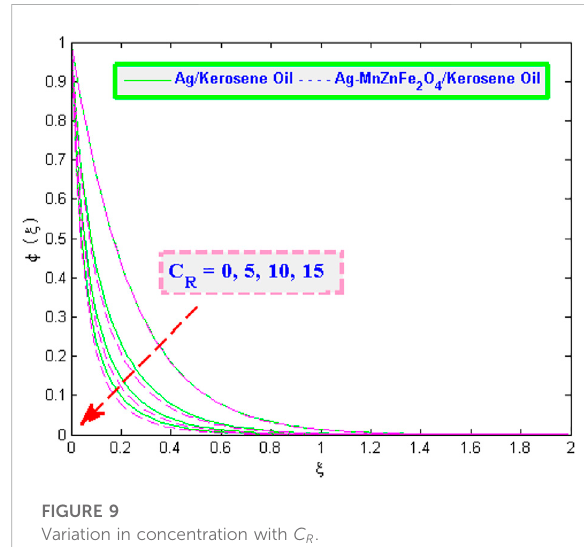
FIGURE 7 Variation in temperature with λ s